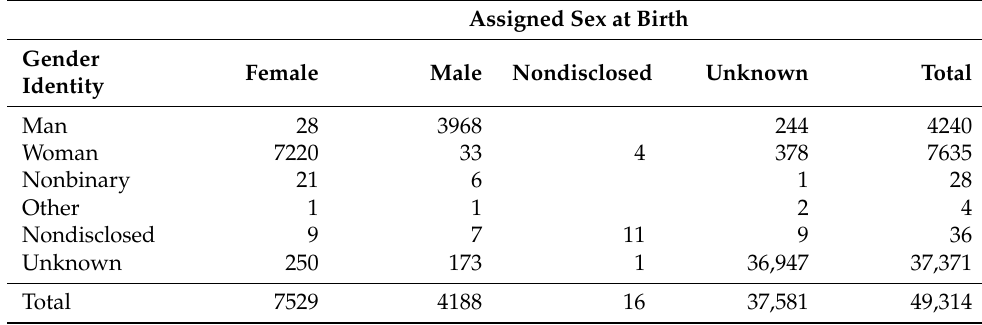
Nondisclosed Unknown Total Table 2. Legal sex, assigned sex at birth, and gender identity data ( n = 9) that were illegible as cisgender or transgender status among the 2020 cohort of unique patients with unplanned admissions. Error Labels Corrected Labels Illegible Gender Identity Cisgender Transgender Legal Sex/ASAB/GI n = 9 F/F/F M/M/M F/M/F M/M/F F/M/M M/M/TM M/F/F 1 For sexual orientation, 80% ( n = 39,862) of data fields were unpopulated (see Table 3). No patients’ SO data field contained the response option “Choose not to disclose.” Although these are not response options in Epic’s Demographic SO section, 13 patients had an SO data field indicating a “transgender” sexual orientation, and 28 patients had an SO data field indicating “neither exclusively male or female” as their sexual orientation. Excluding those 41 patients, 3.4% ( n = 322) of all patients with populated SO data fields expressed a lesbian, gay, or bisexual sexual orientation. If we added the 28 nonbinary patients, who